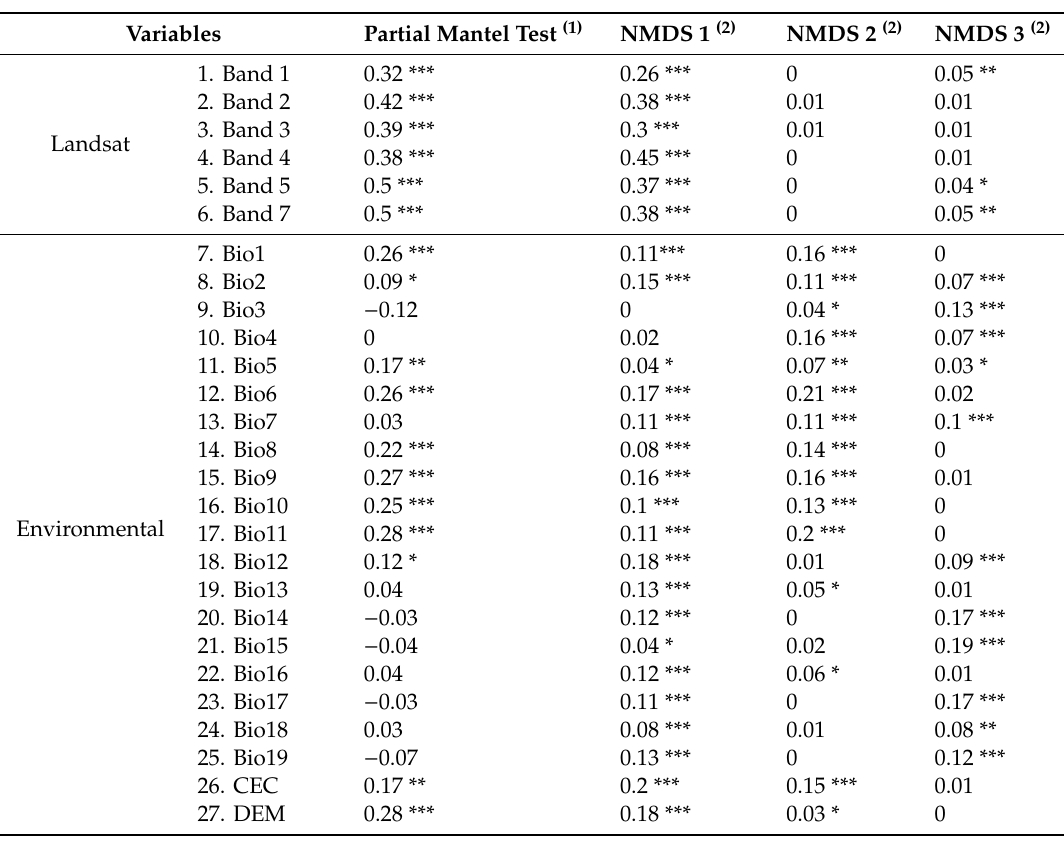
Table 1. Relationships between the genus-level floristic composition of trees and environmental and Landsat variables. (1) Correlation values of partial Mantel tests between the distance matrices of the floristic composition and each of the Landsat and environmental variables separately, partialling out the correlation with the geographical distance. Statistical significance of each correlation coe ffi cient was assessed with a Monte Carlo permutation test using 999 permutations. (2) Pearson correlation coe ffi cientsofsimplelinearcorrelationbetweeneachofthefloristicordinationaxes(NMDS1–3)andeach Landsat and environmental variable. *** p < 0.001, ** P < 0.01, * p < 0.05. Bands 1–7 refer to the Landsat bands, Bio1-19 refer to each of the bioclimatic variables (http: // chelsa-climate.org / bioclim / ), CEC refers to soil cation exchange capacity, and DEM refers to elevation. The full names and abbreviations of all variables are listed in Table